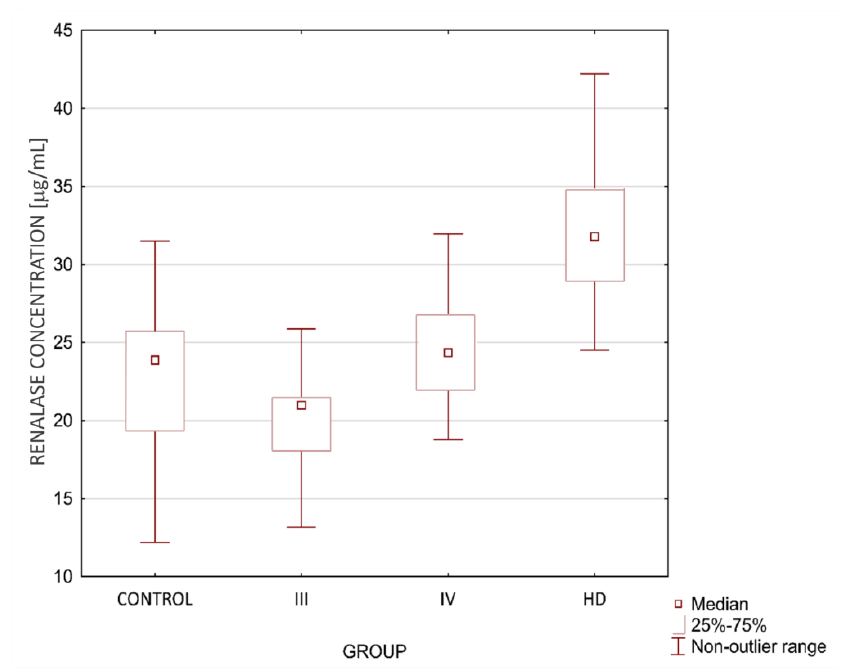
Figure 1. Renalase levels in the studied groups.